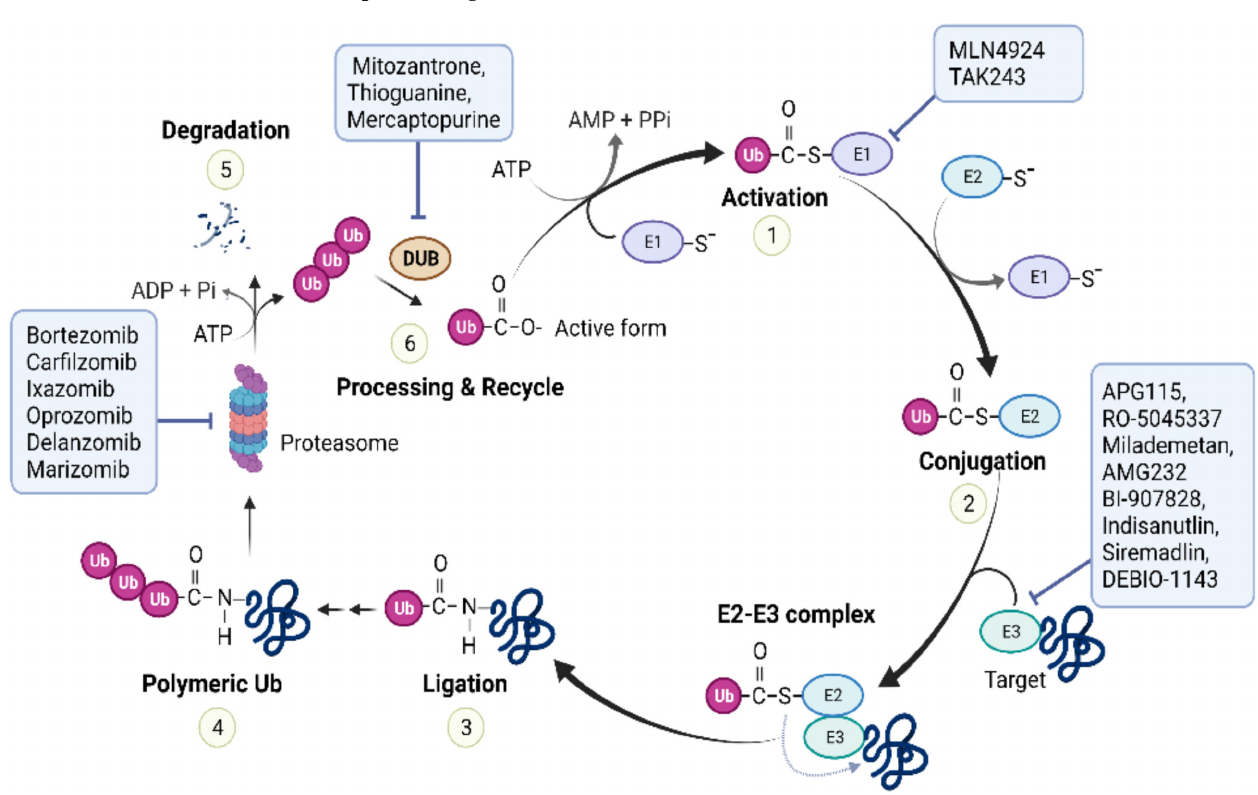
Figure 2. The ubiquitin-proteasome system (UPS). In step 1, ubiquitin is activated by a ubiquitin activating enzyme (E1). In step 2, activated ubiquitin (Ub) is transferred to a ubiquitin conjugating enzyme (E2). In step 3, ubiquitin is transferred from E2 to a specific target (substrate) lysine to form a covalent bond. This process is catalyzed by E3 ubiquitin ligase. In step 4, repeated ubiquitin conjugation generates a poly-ubiquitin chain. In step 5, the ubiquitinated target (e.g., canonical K48 linkage) is recognized, unfolded, and digested by the 26S proteasome. In step 6, Deubiquitinating (DUB) enzymes remove covalently linked ubiquitin moieties from ubiquitin-ubiquitin and ubiquitin- protein conjugates. These enzymes also process ubiquitin precursors to generate free (un-anchored) ubiquitin pools. The free ubiquitin can be further reused. Inhibitors of various UPS components are being developed clinically for the treatment of cancer and neurodegenerative